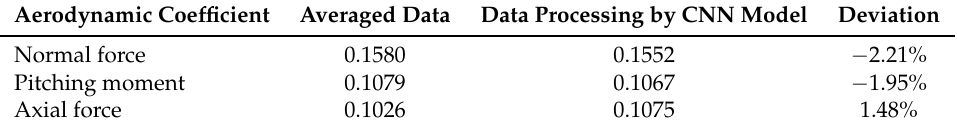
Table 2. Comparison of the test data processing carried out by the direct average method and the CNN